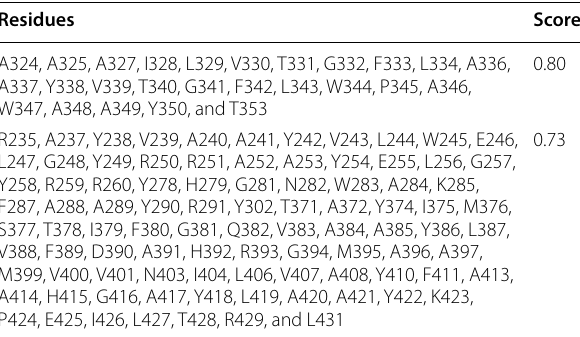
Table 3 The B cell conformational epitopes with a PI score greater than 0.7